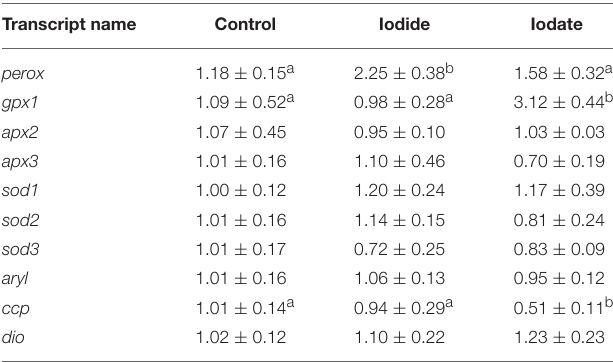
TABLE 4 | Expression levels of perox , gpx1 , apx2 , apx3 , sod1 , sod2 , sod3 , aryl , ccp, and dio in T. lutea cultures at 3h after iodide (5mM) or iodate (5mM).